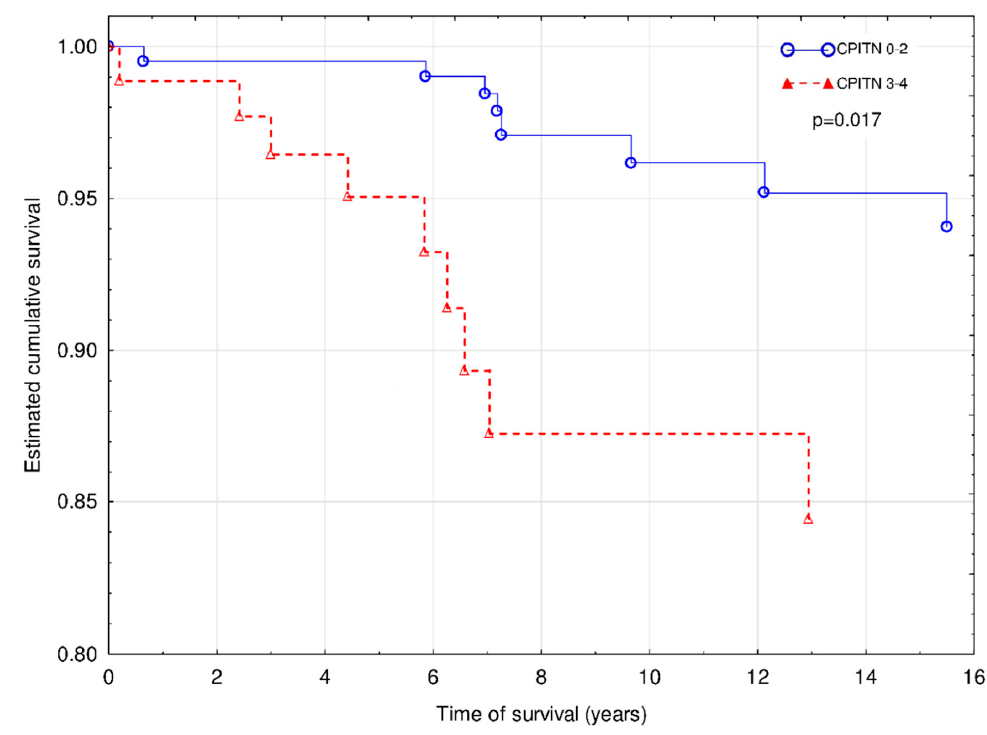
Figure 2. Mortality of patients with a functioning graft with CPITN (0–2) and CPITN (3–4). Covariates: age, sex, IMT, and MACE.